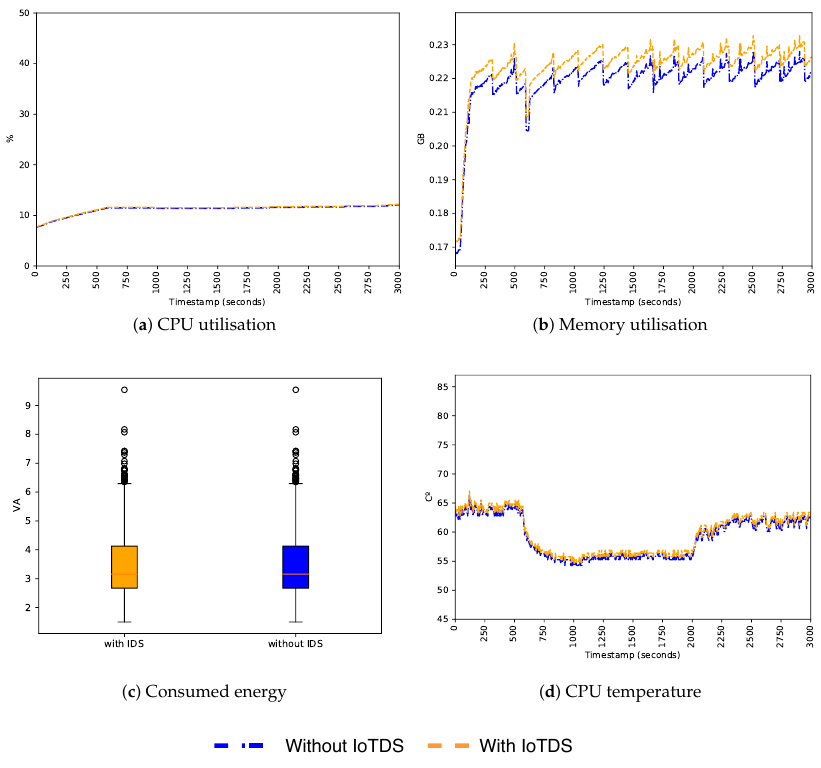
Figure 11. Behaviour of the SC profile infected with botnets regarding resource usage with and without the